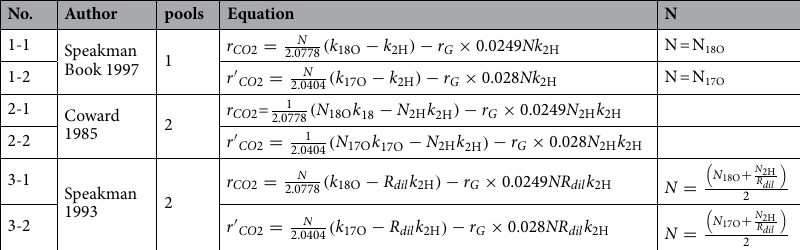
Table 3. CO 2 production (r CO2 ) calculation equations by the doubly labelled water method separately based on 18 O or 17 O with 2 H 4,45,46 .